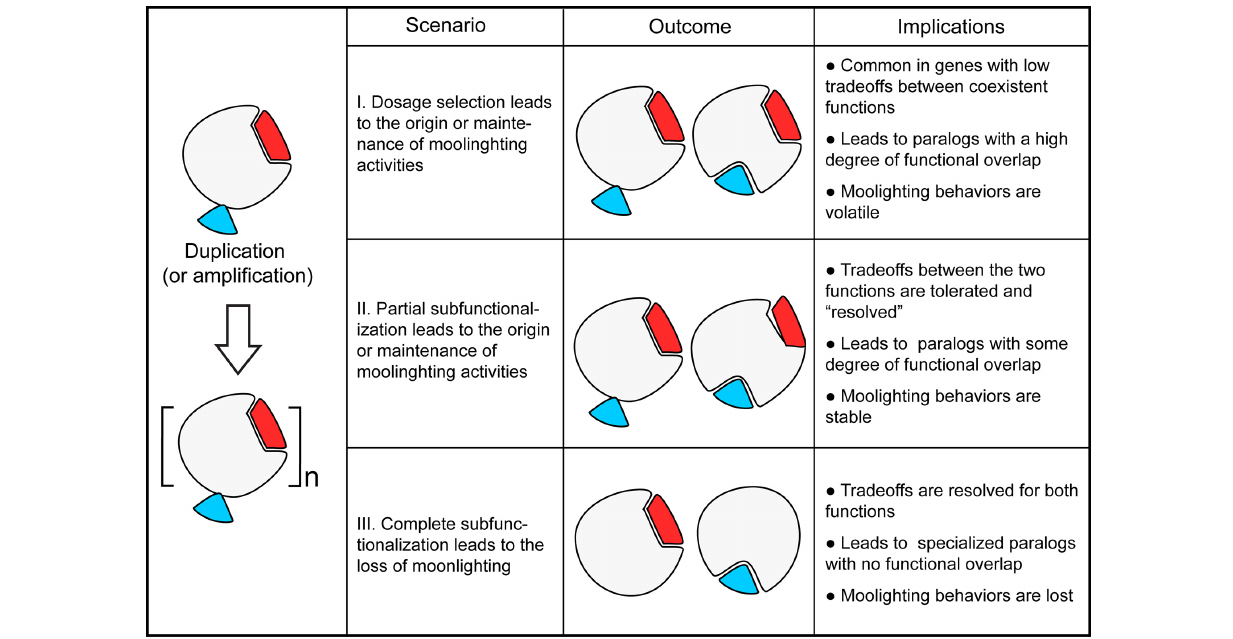
enable the origin or retention of moonlighting behaviors as a result of neutral evolution (e.g., yeast Eno1/Eno2). In this scenario, the subfunctionalization may act on gene expression or protein activity, e.g., substrate specificity. (III) In contrast, duplication may result in the loss of moonlighting behaviors of one of the paralogs (e.g., yeast Gal1/Gal3), or of in both gene products (e.g., chicken argininosuccinate lyase/ δ -crystallins) by complete specialization of their molecular